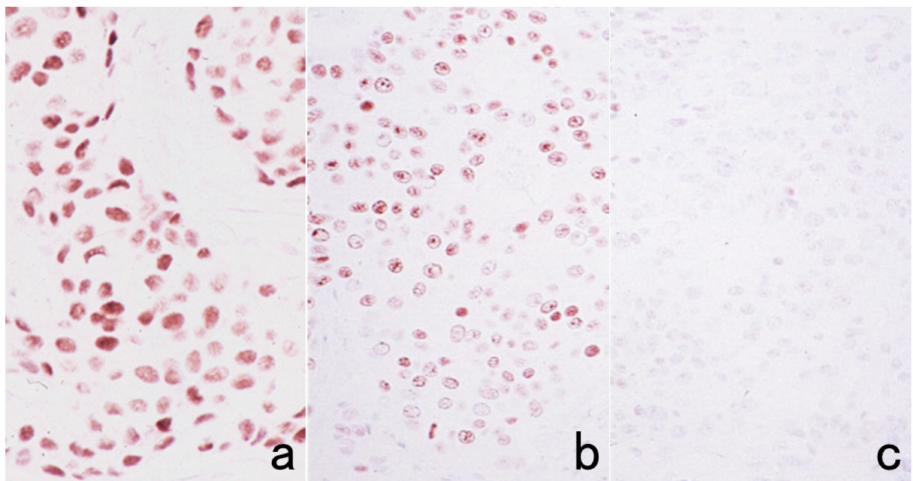
Figure 24. Effect of prolonged storage of unstained sections (HIER-assisted ER immunostaining for breast cancer). Immunostaining just after cutting ( a ) and immunostaining after prolonged storage for 6 months in a − 20 ◦ C freezer ( b ) or at room temperature ( c ). The prolonged storage at room temperature severely deteriorates the immunoreactivity of nuclear antigens such as ER. Storage in a freezer is effective for avoiding such false